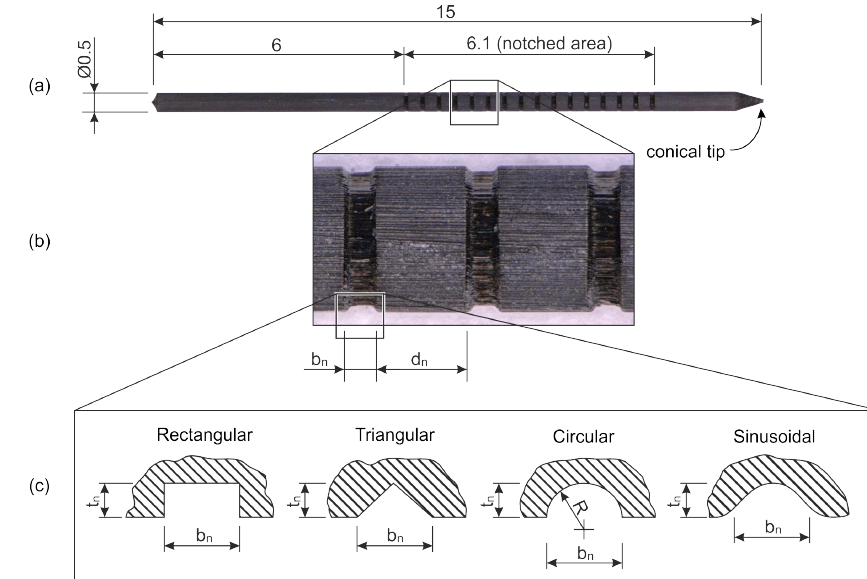
Figure 2. Definition of circumferential notches at the z-pin surface: ( a ) position and length of notched area at the z-pin surface, ( b ) definition of notch geometry, ( c ) different notch designs evaluated.